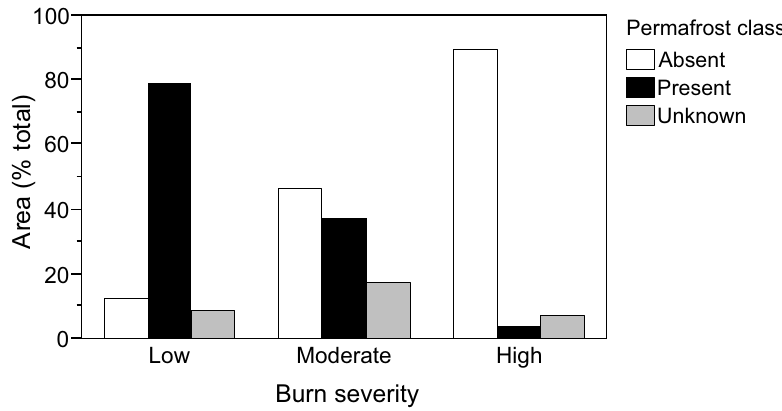
Figure 10. Distribution of mapped permafrost classes by dNBR-derived burn severity (Landsat 7 ETM+).